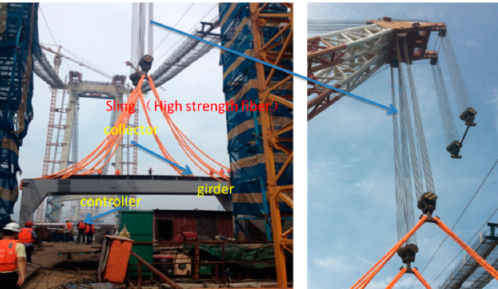
Figure 14. On-site hoisting.